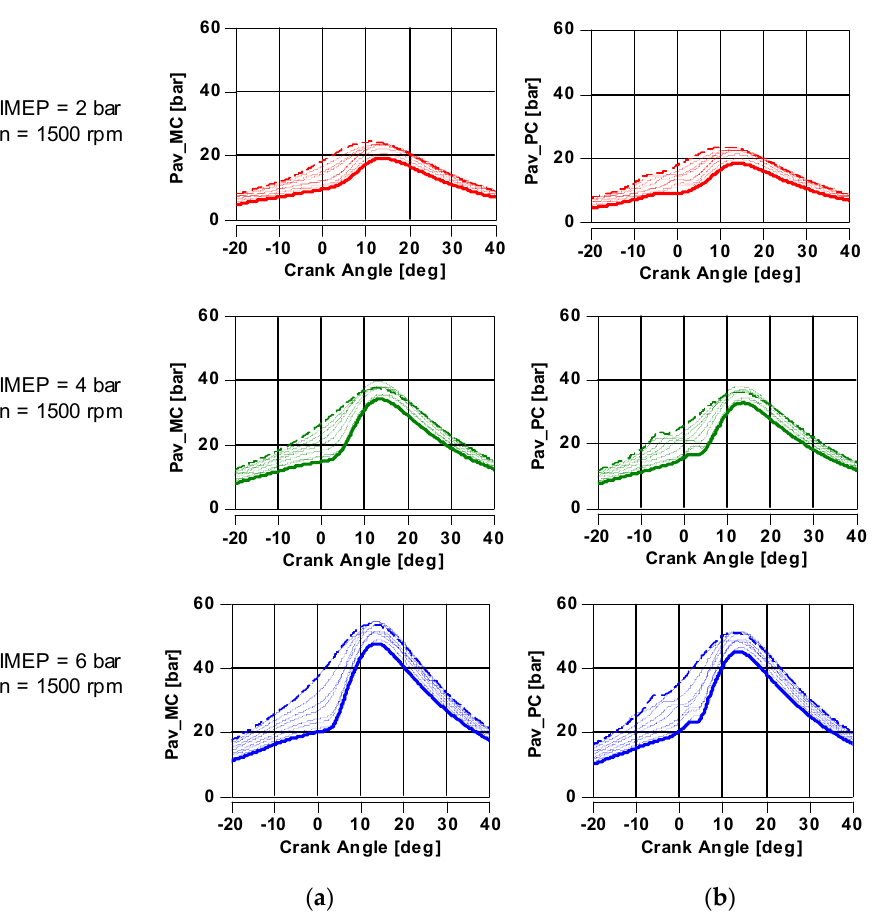
Figure 9. Pressure value in the cylinder: ( a ) in the main chamber; ( b ) in the prechamber. Changing the value of the excess air coefficient caused the start of combustion to be advanced (due to the necessity to meet condition (2)) depending on the average indicated pressure: